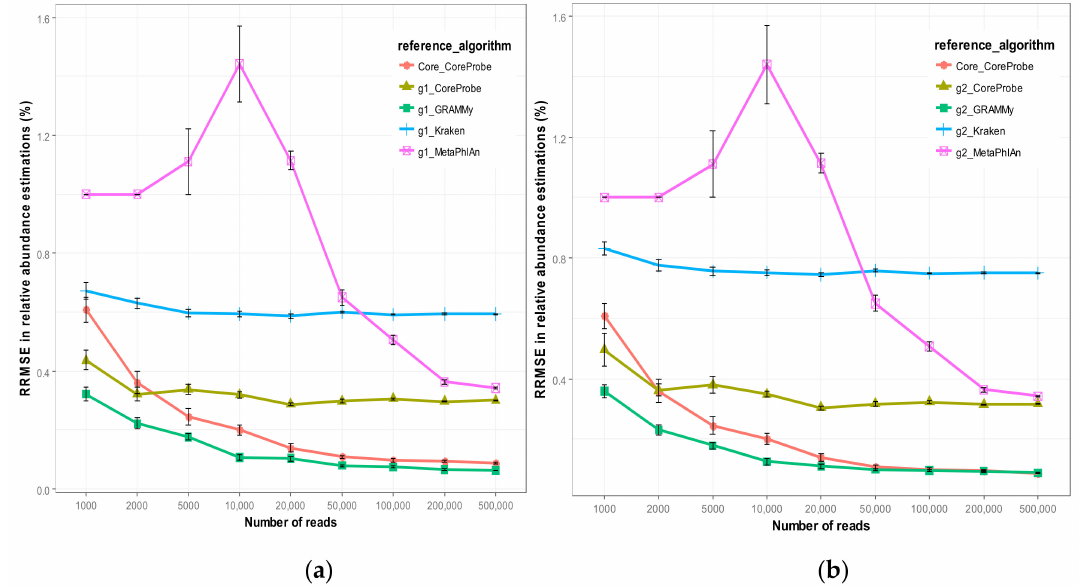
Figure 3. The relative mean square error of the relative abundance of each algorithm. ( a ) The selected strain as a reference genome is contained in a sequence of strains used to generate simulated metagenomic datasets as g 1 ; and ( b ) the selected strain as a reference genome is contained in a sequence of strains used to generate simulated metagenomic datasets as g 2 . The abscissa represents the different metagenome simulation data set of the reading capacity, and the ordinate is the mean square error of the algorithm relative abundance between the estimated value and the preset